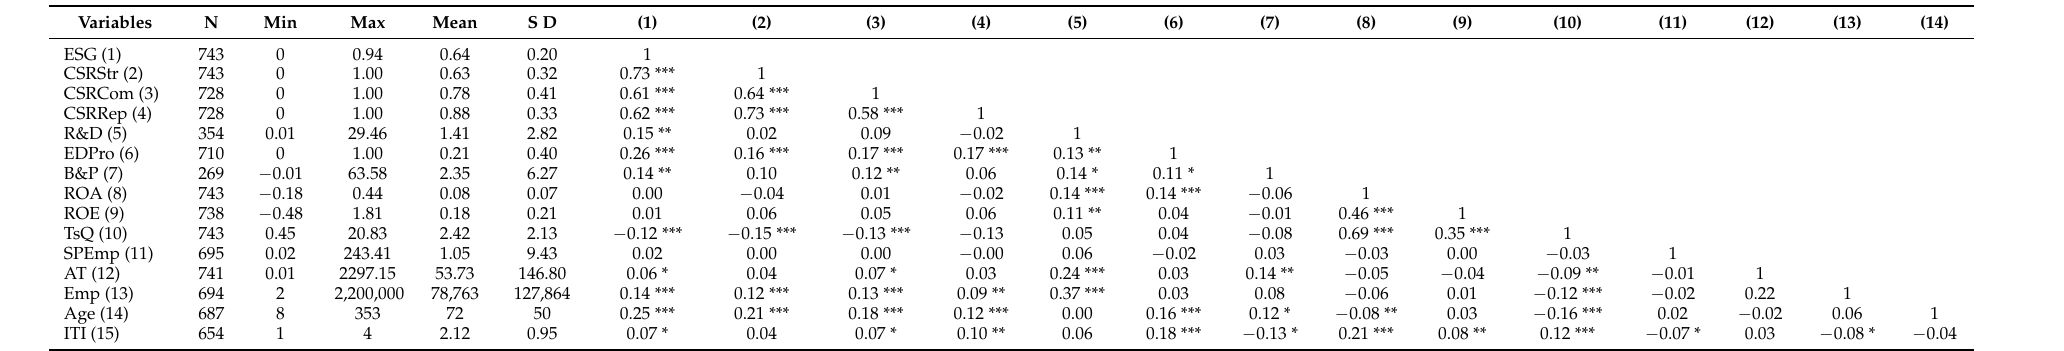
Table 7. Descriptive statistics and